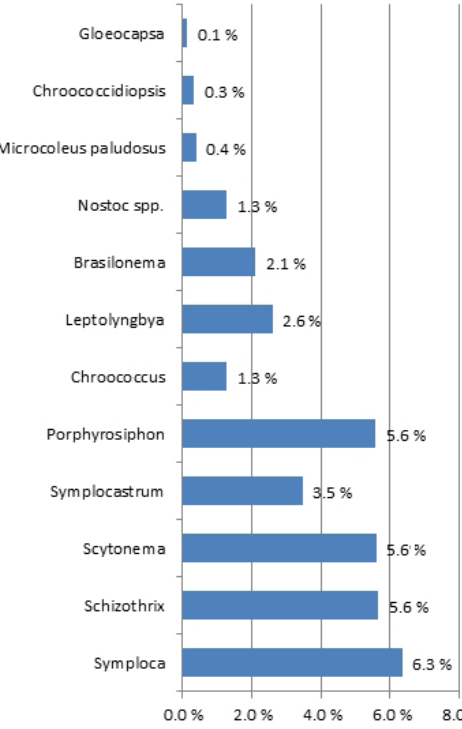
Figure 4. Cyanobacterial community structure across all sites ex- pressed as a percentage of the total community based on mean rich- ness and abundance scores. N-fixing cyanobacteria contributed to 61% of the community structure.